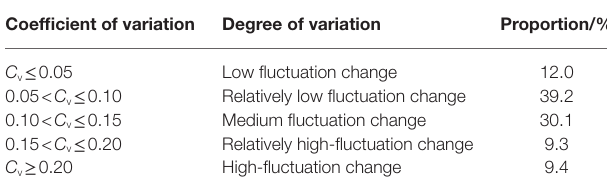
TABLE 2 | Coefficient of variation statistics of the NDVI from 2001 to 2020 in Tibet. Coefficient of variation